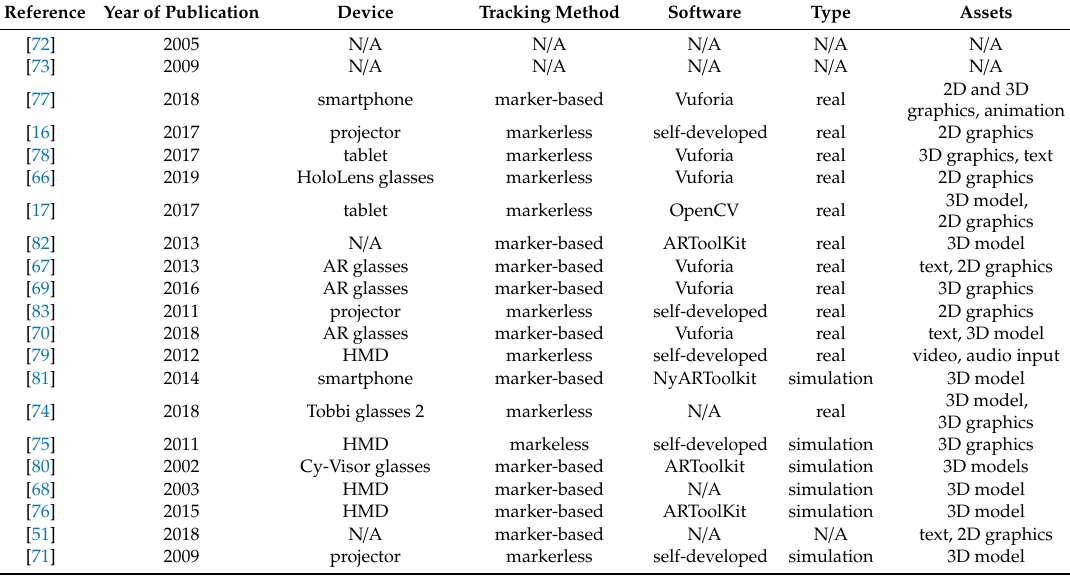
Table 3. General characteristics of AR application that are not related to driving.